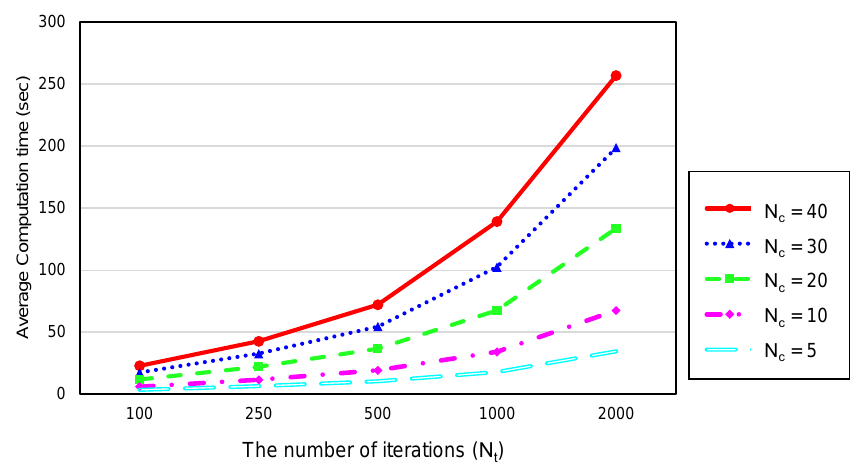
Figure 7. Average computation time against N c and N t